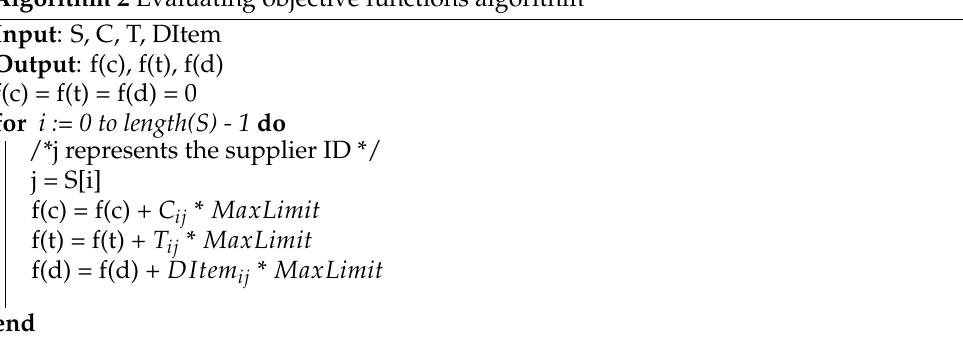
Algorithm 2 Evaluating objective functions